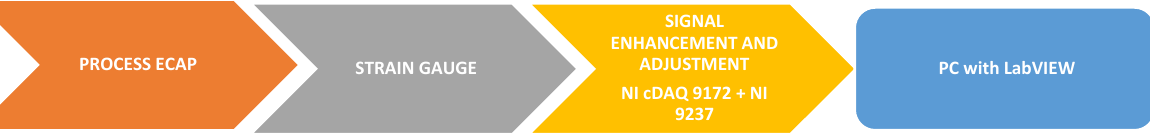
Figure 2. Diagram of the ECAP die used [28].